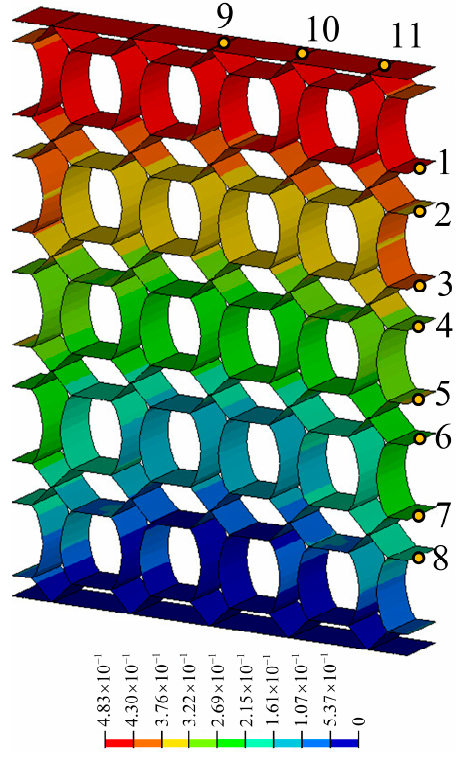
Figure 6. Displacement contour plot of metamaterials with 𝜈 = +1.0 .